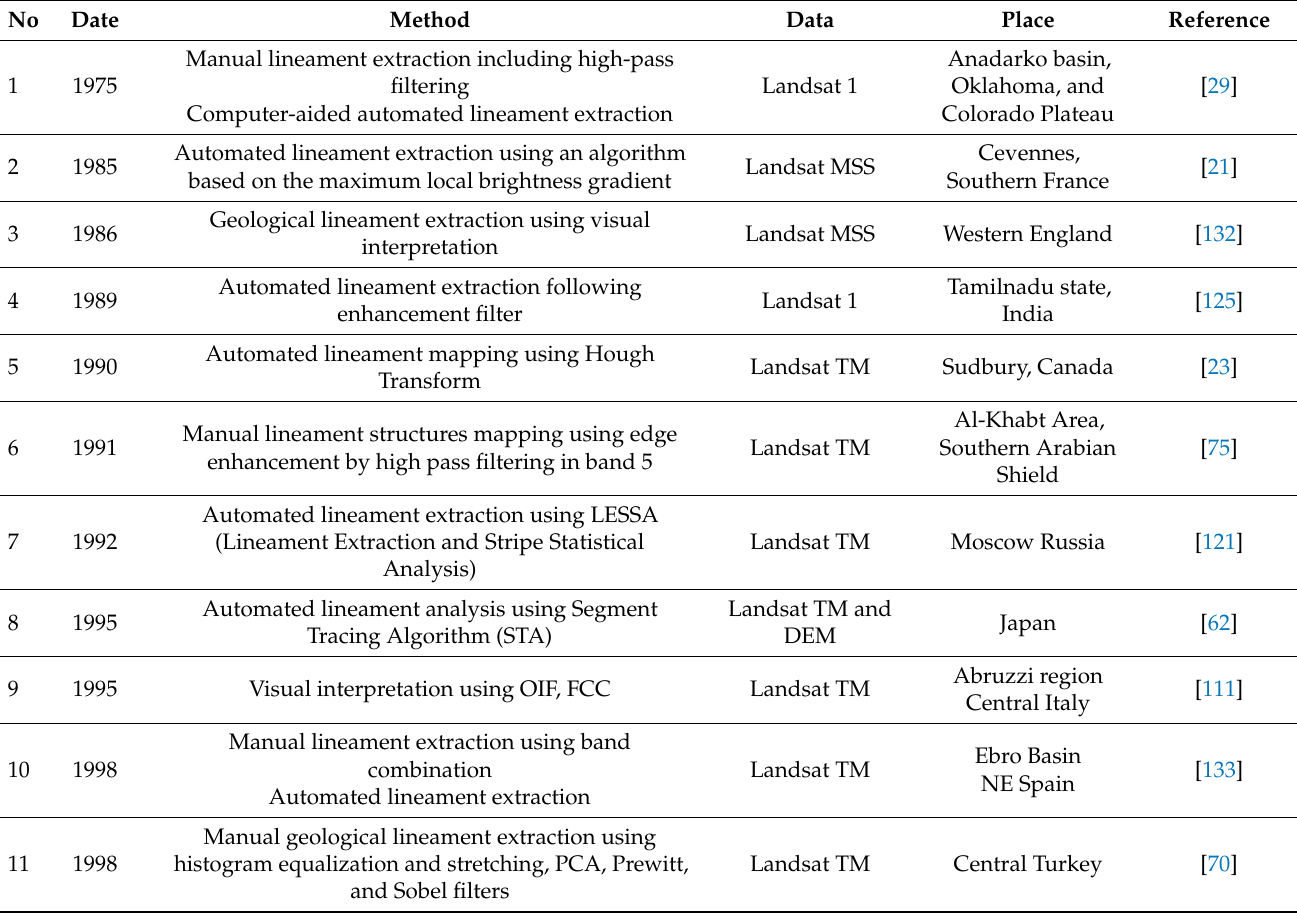
Table A1. Geological lineament detection using various techniques between 1975 to